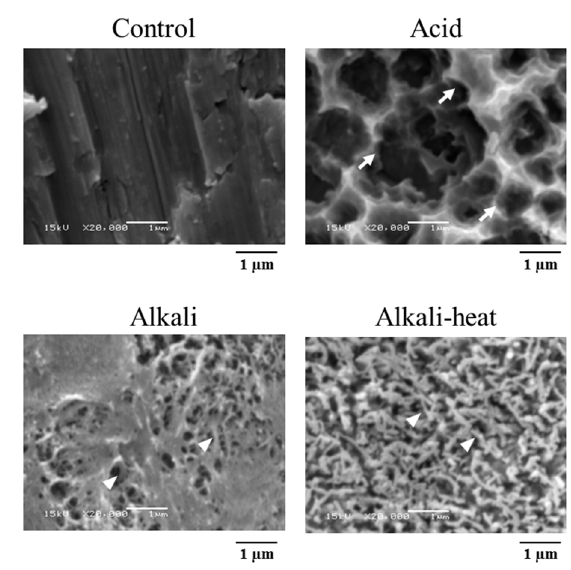
Figure 4. SEM images of the surface-treated MDF-Ti disks.